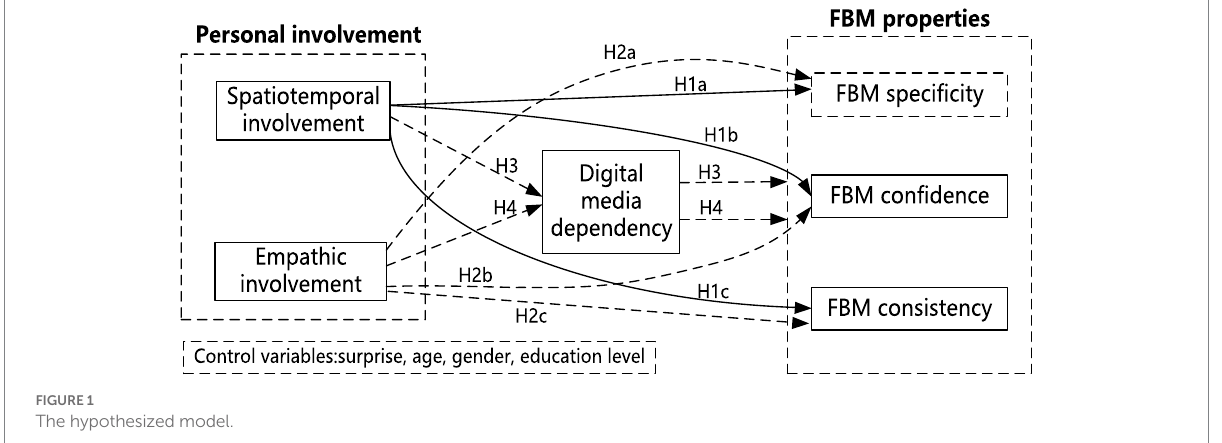
FIGURE 1 The hypothesized